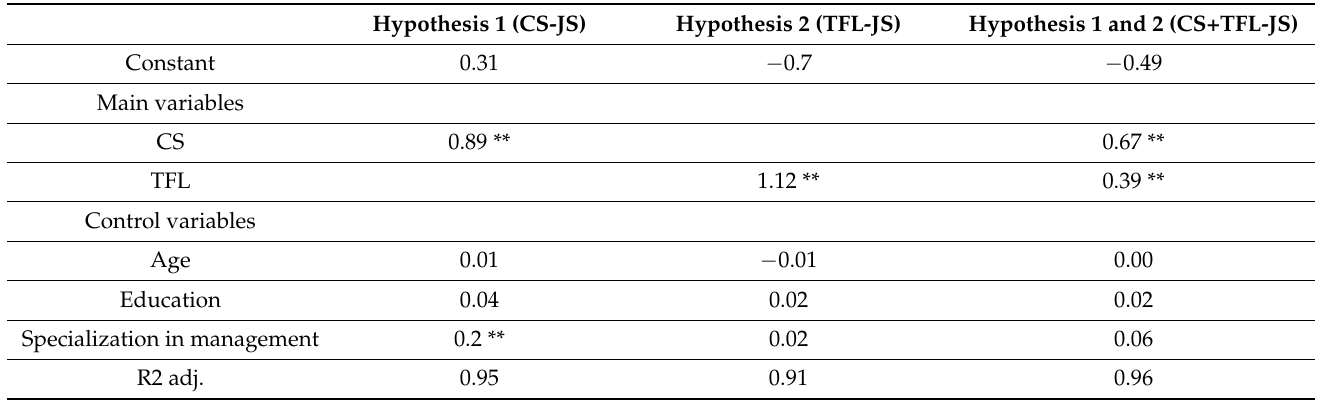
Table 2. Results of regression analyzes for two predictors (JS is the dependent